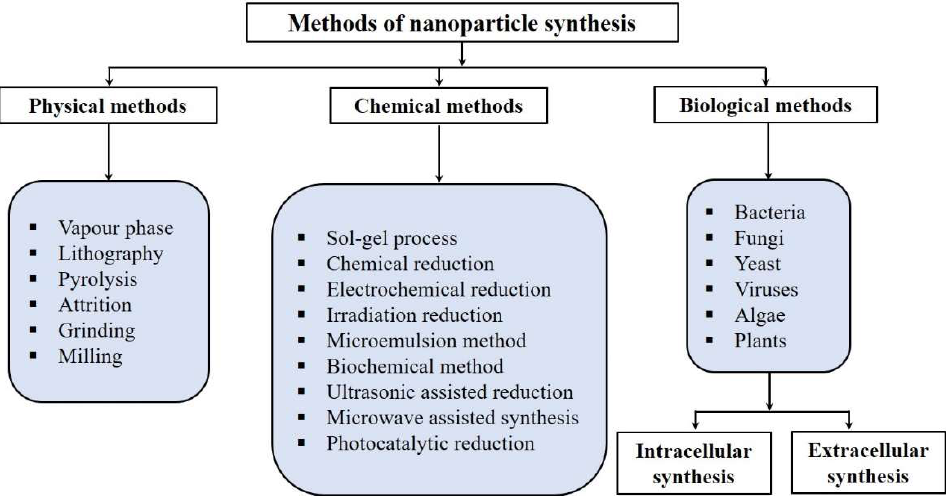
Figure 1. Different methods of NPs synthesis.